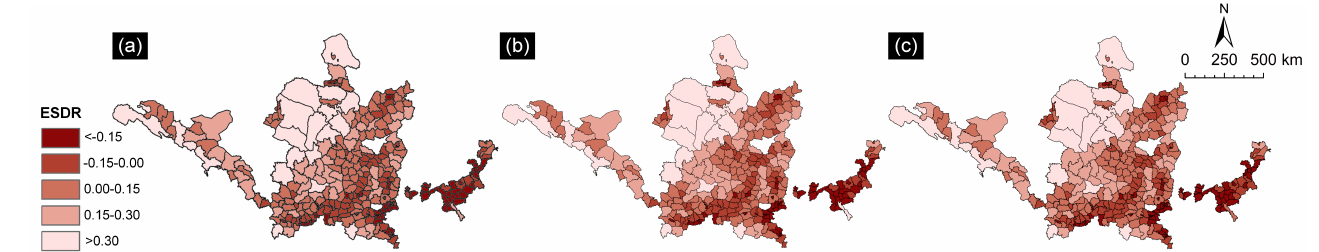
Figure 5. Coordination degree of ES supply-demand in resource-based cities in the YRB from 2000 to 2020. ( a ) 2000; ( b ) 2010; ( c )